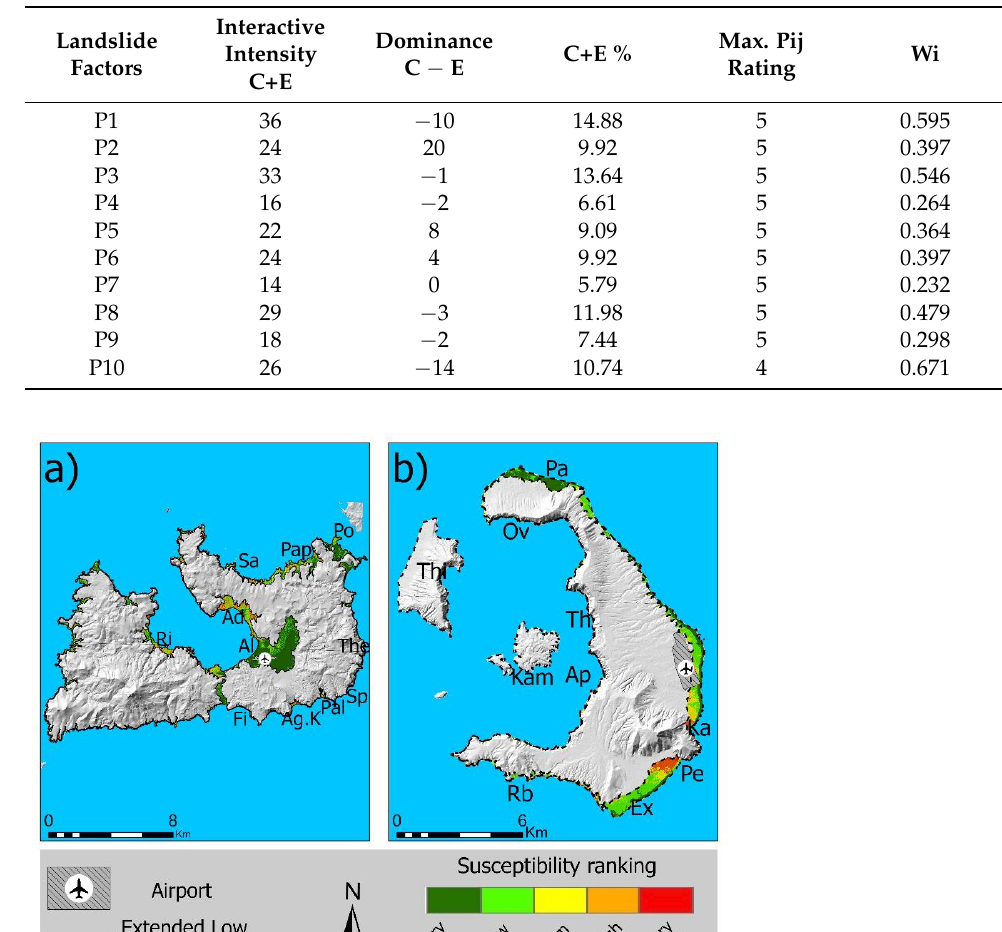
Table 5. Interactive intensity, dominance and weighted coefficients of the principal factors in the RES method for Milos and Thira Islands.